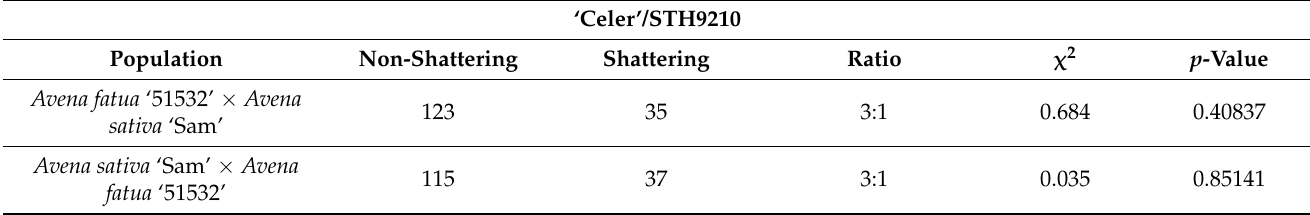
Table 3. Segregation ratios of shattering in F 2 progeny from the cross Avena fatua ‘51532’ and Avena sativa